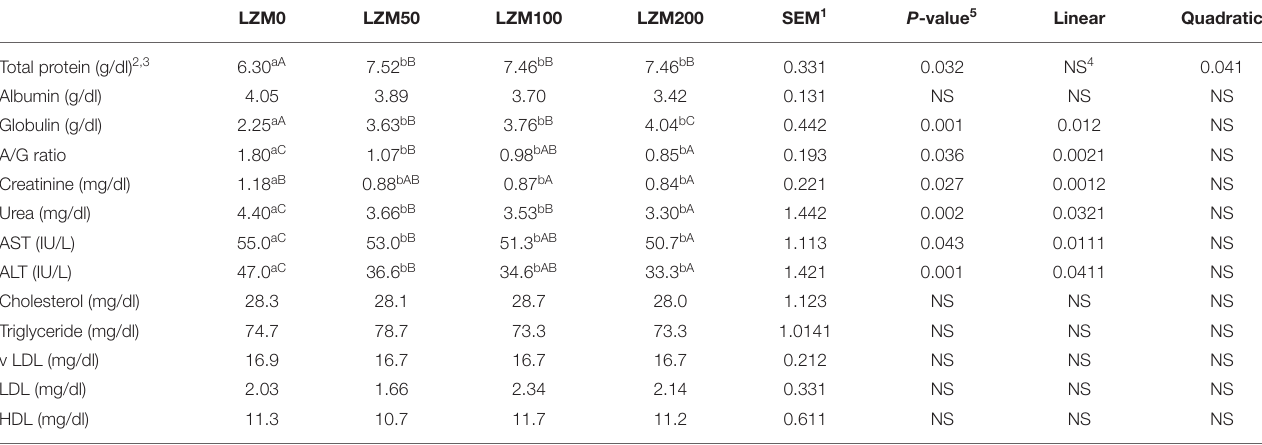
TABLE 5 | Effect of varying levels of chicken egg lysozyme (LZM) on biochemical blood variables of growing rabbits. LZM0 LZM50 LZM100 LZM200 SEM 1 P -value 5 Linear Quadratic Total protein (g/dl)